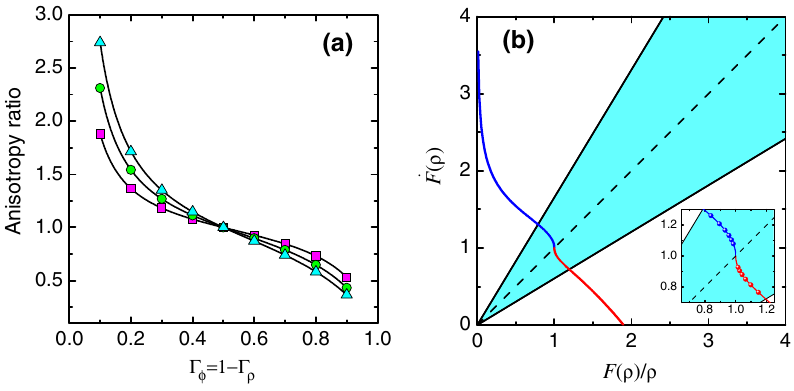
= κ σ = σ FIG. 7. (a) Anisotropy ratio κ ρ ; ϕ ; eff or ρ ; eff ϕ ; eff attainable from Eqs. (8 eff σ σ κ ≪ κ σ ≪ σ 2 ¼ 0 , with 2 0 and 1 0 ) as a function of the depolarization factor f f 0 . 1 , 0.15, 0.2 (square, circle, and triangle markers, respectively). (b) Representation of the anisotropy-ratio bounds in the 1 ¼ 2 ¼ _ F space ð ρ Þ versus F ð ρ Þ = ρ , assuming f 1 ¼ f 2 ¼ 0 . 2 . The cyan-shaded angular sector represents the allowed region, and the dashed bisector represents the identity transformation. Also shown are the curves pertaining to the concentrator (red) and cloak (blue) coordinate transformations in Fig. 3(a). The inset shows a magnified view of the allowed portions of these curves, with the markers corresponding to the discretized samples in Fig.